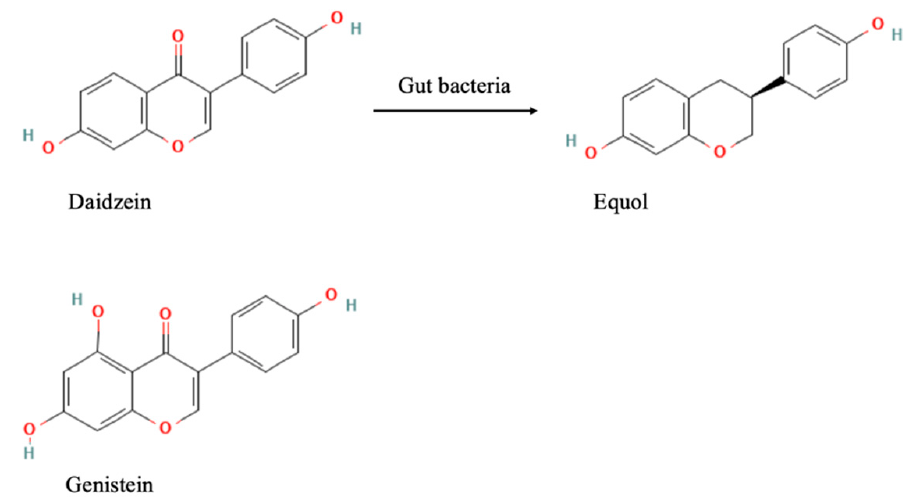
Figure 2. Structures of genistein, daidzein, and equol [48–50]. Genistein and daidzein are two major ISFs and comprise >95% of dietary sources. Equol is a metabolite of daidzein, biotransformed by gut bacteria.